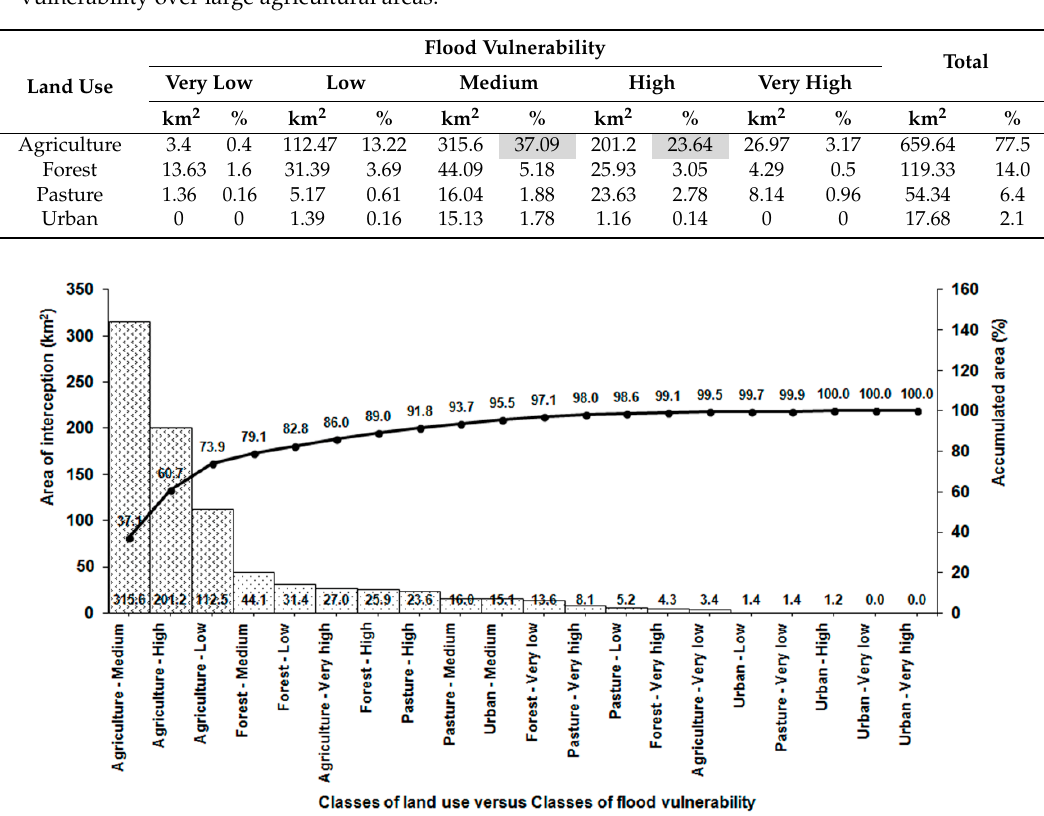
Figure 8. Pareto diagram illustrating the frequency of land use conflict versus flood vulnerability classes in the municipality of Batatais SP.